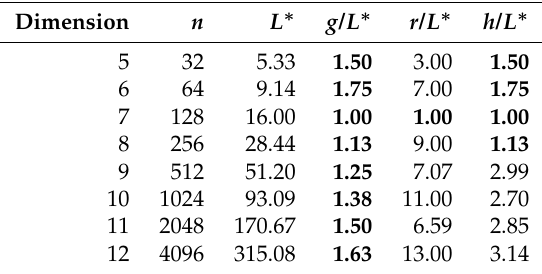
Table 6. Results for Hypercubes.